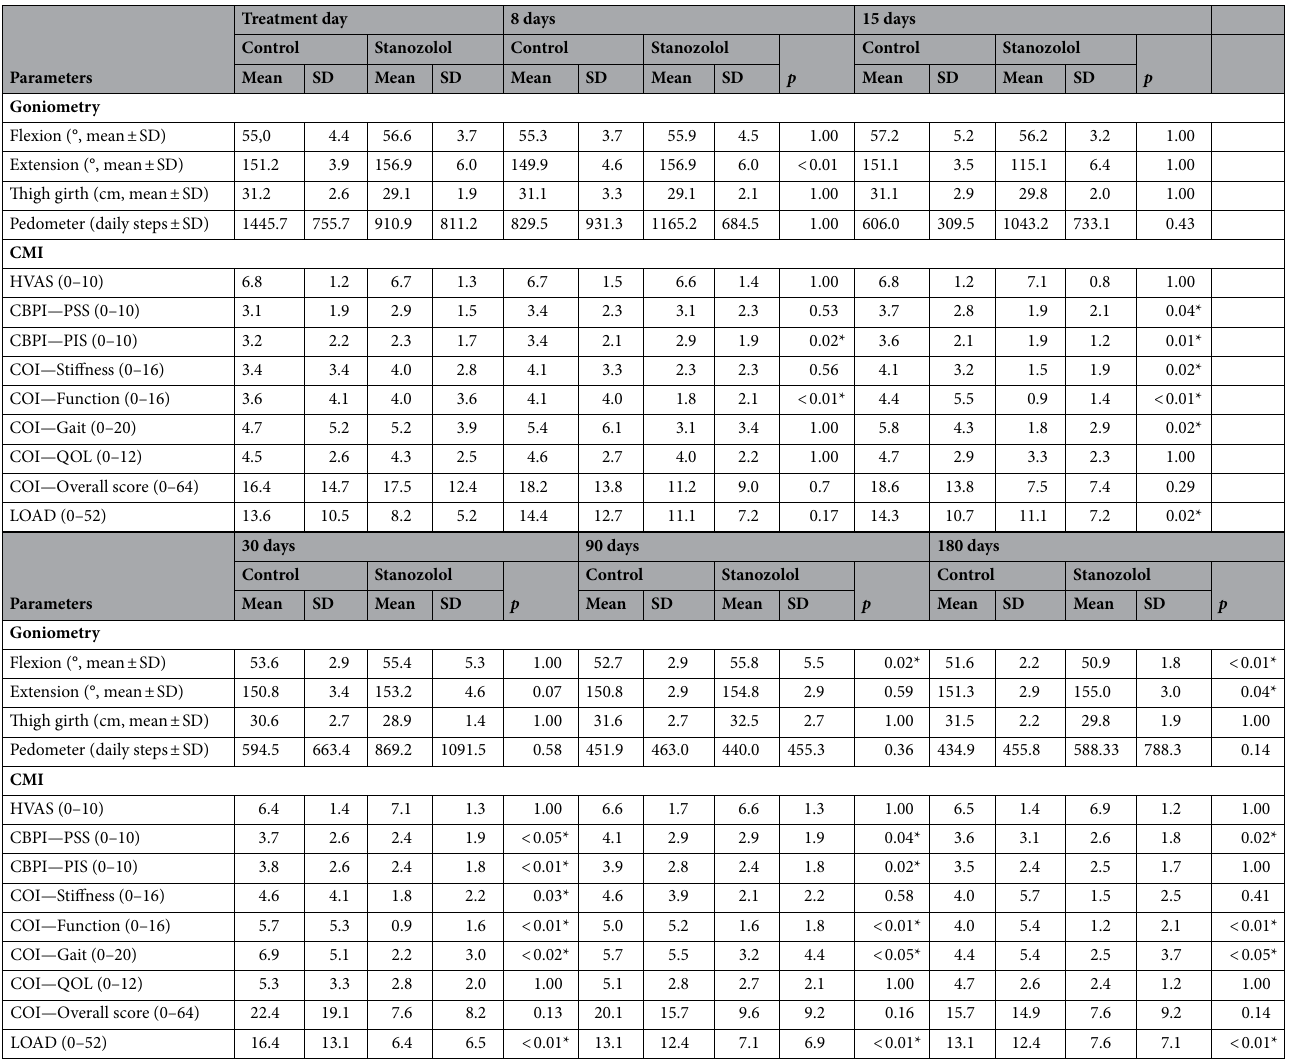
Table 1. Mean values (± standard deviation) of goniometry, thigh girth evaluation, pedometer and Clinical metrology instruments evaluated throughout the study. CBPI Canine Brief Pain Inventory, COI Canine each follow-up moment are presented. * Indicates